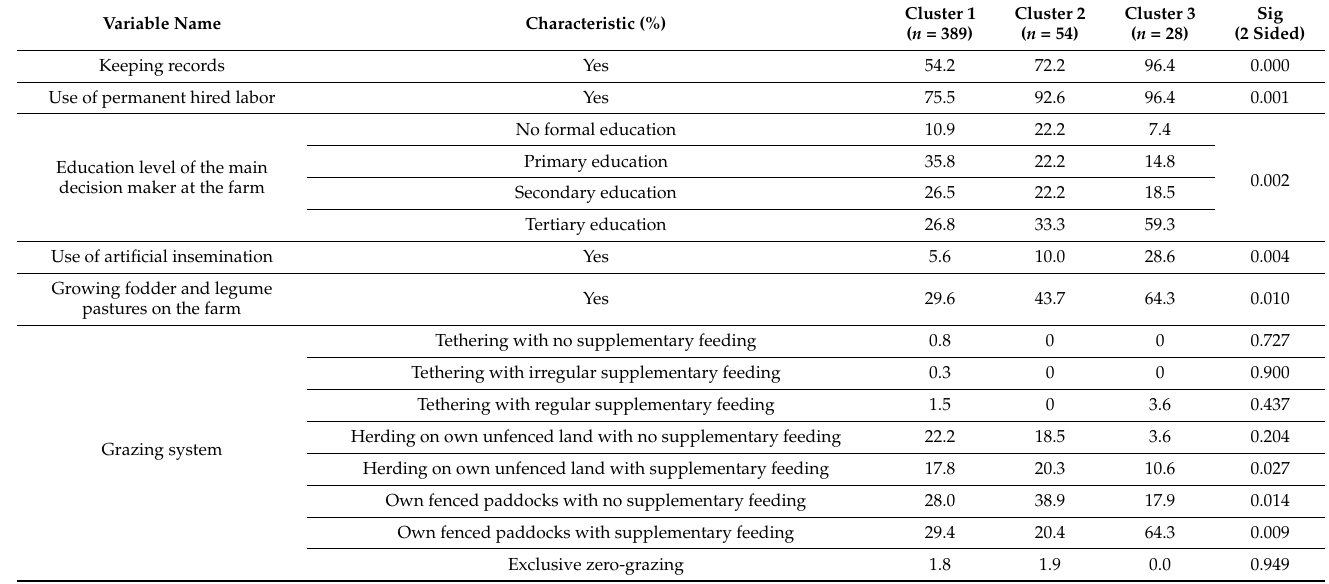
Table 6. Categorical variables that characterize the three dairy cattle farm